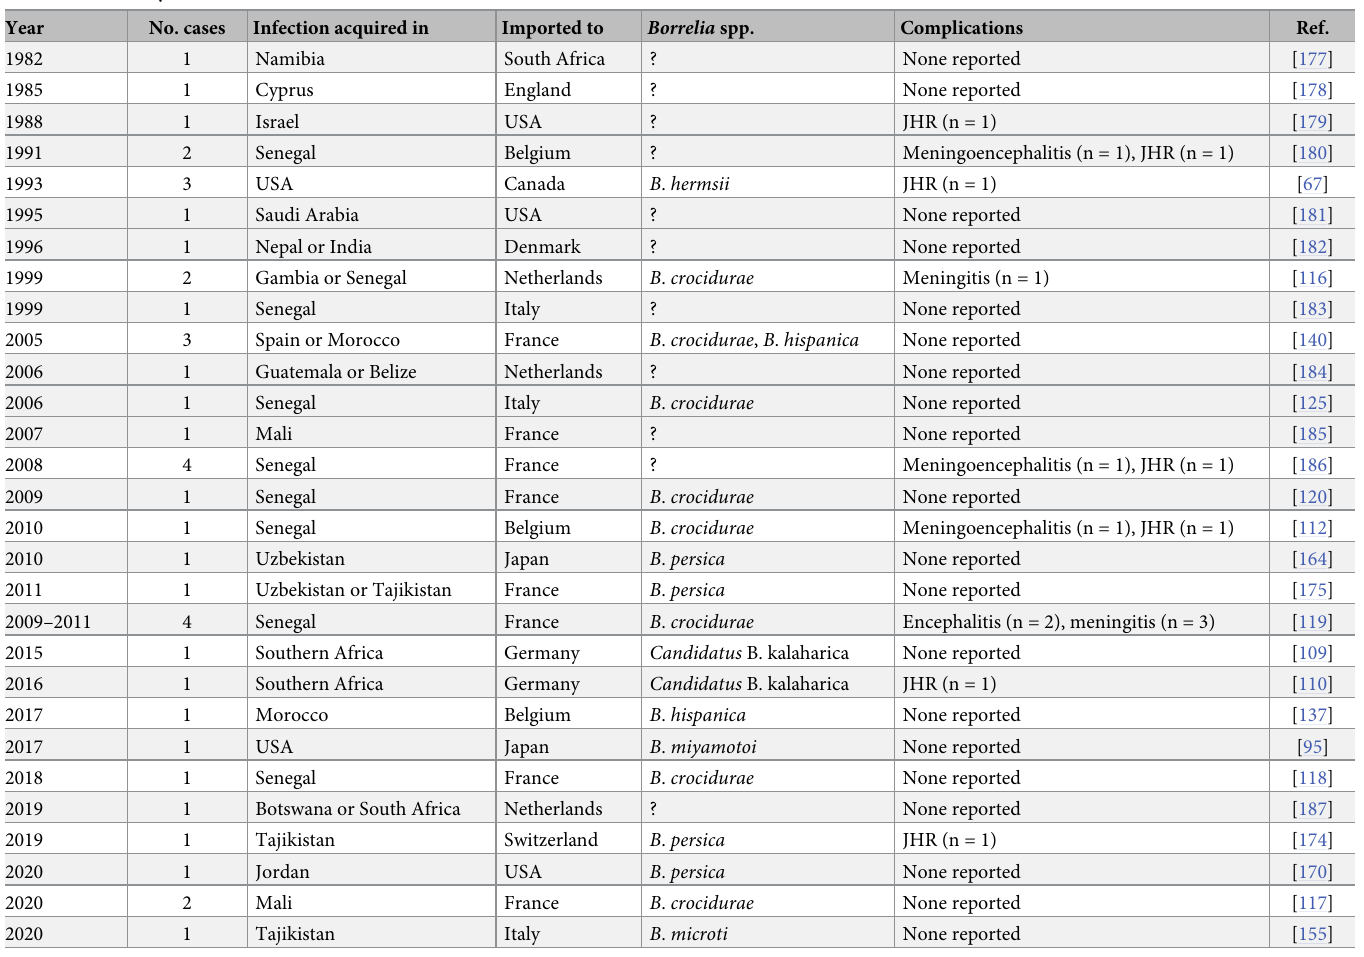
Table 5. Case analysis on TBRF in